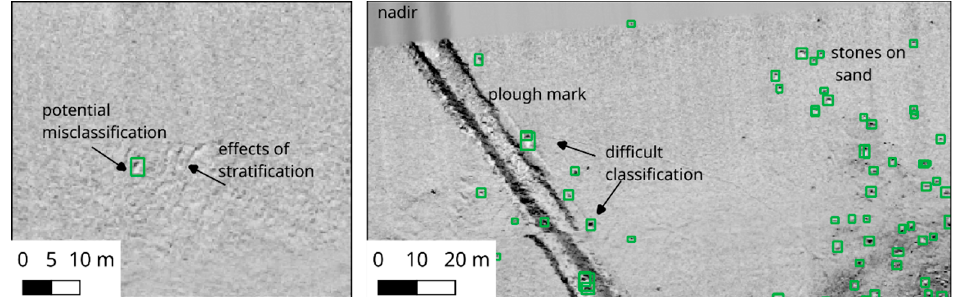
Figure 6. Details of classification results on sand and examples of misclassification due to water column stratification and cable plough marks. All boulder detections are based on the 25 m² model. The underlying mosaic resolution is 0.25 m.